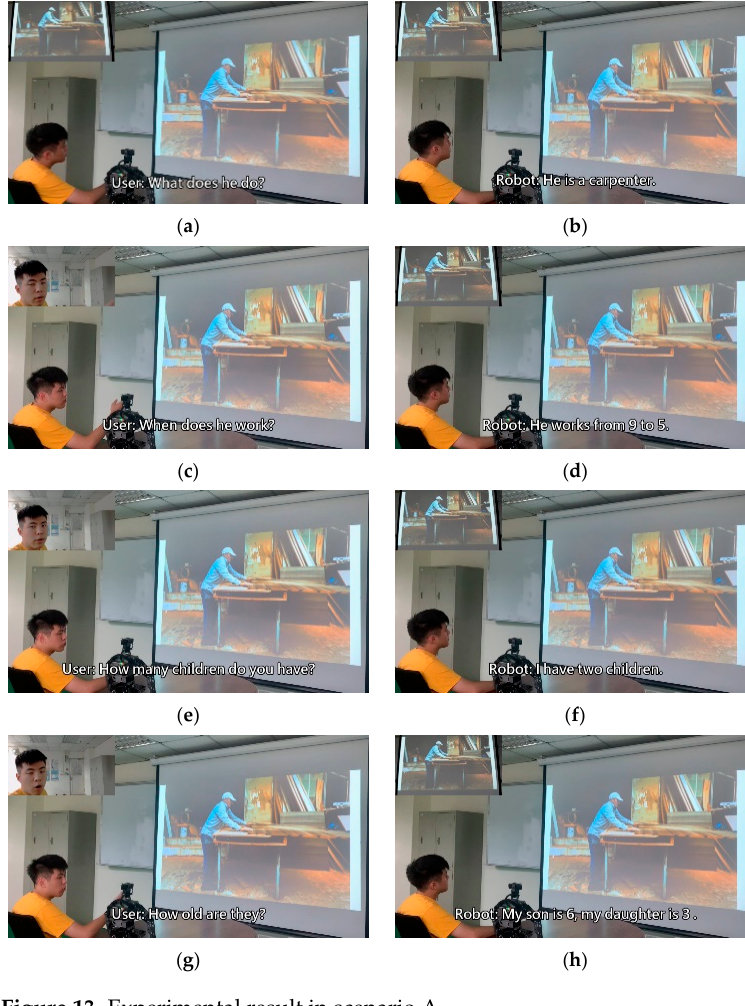
Figure 13. Experimental result in scenario A.